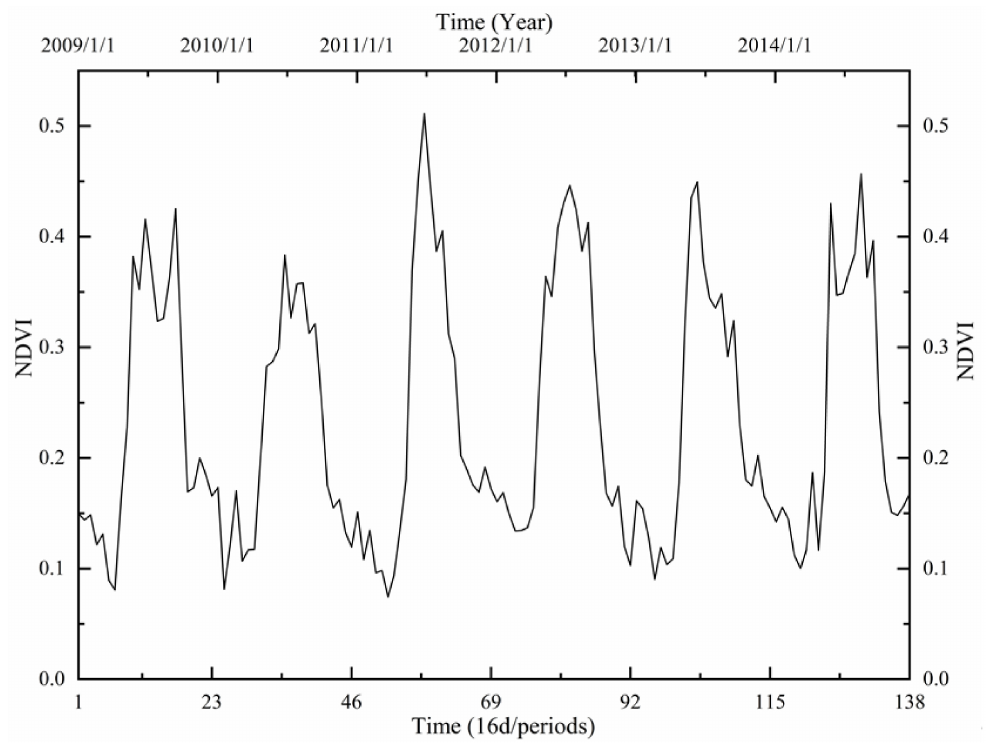
Figure 3. Time series of poplar canopy NDVI at Sampling Site 2 from 2009 to